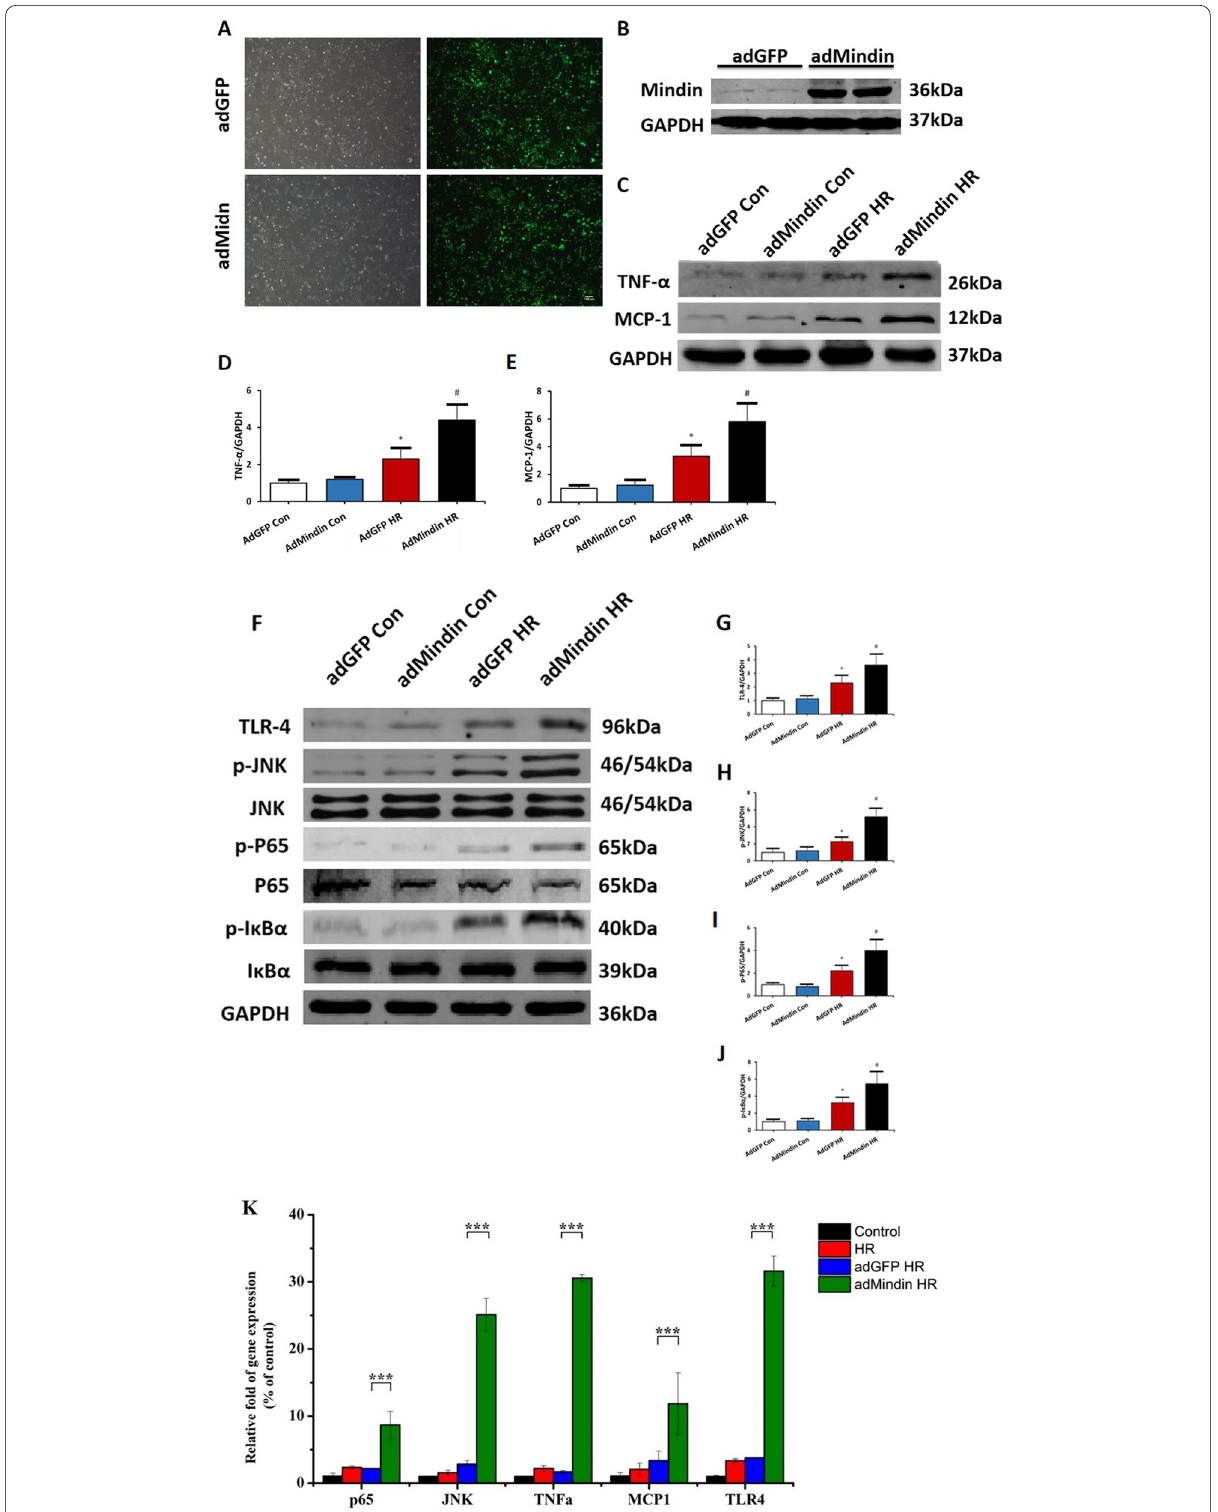
Fig. 5 (See legend on previous